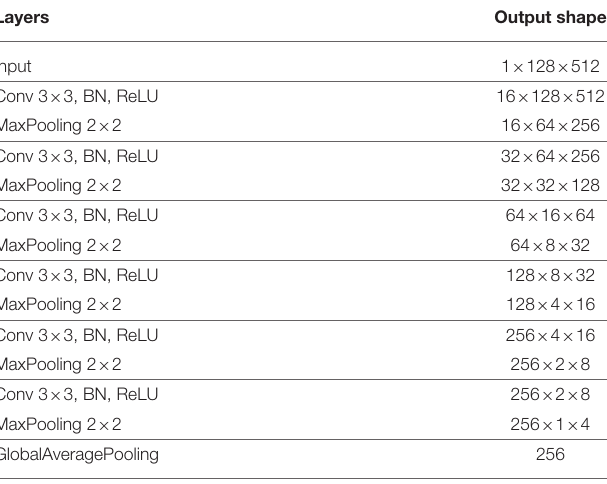
TABLE 1 | Employed network architectures.